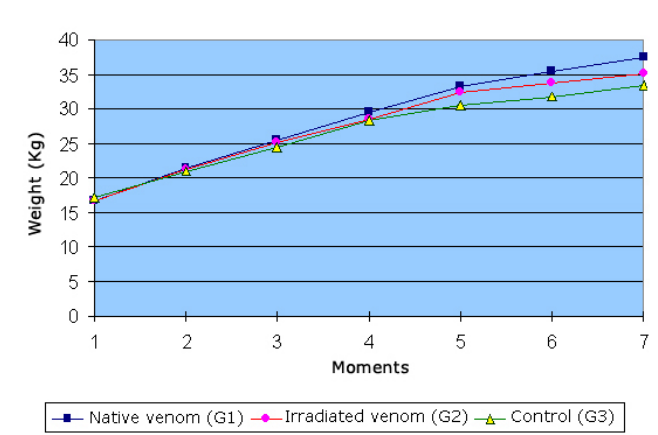
Figure 5: Mean values of total lymphocytes count (/µl) in ovine groups inoculated with natural (G1) and 60 Co- irradiated (G2) C.d.t. venom, and control group (G3), at different moments.